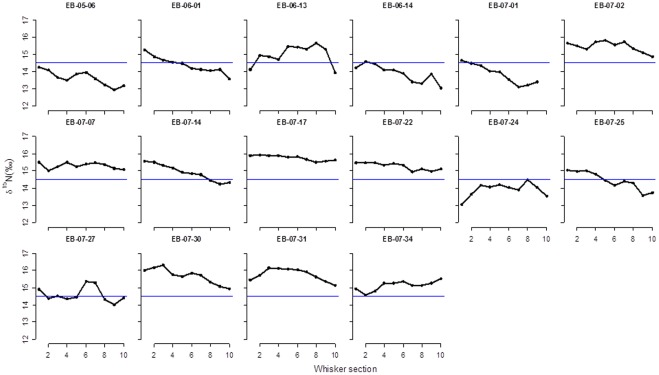
δN profiles for the 16 whiskers collected within two days of birth for bearded seals in Svalbard.The segments are numbered from the basal (most recent) to proximate (oldest) ends. The blue horizontal line represents the overall mean δ15N from all samples.